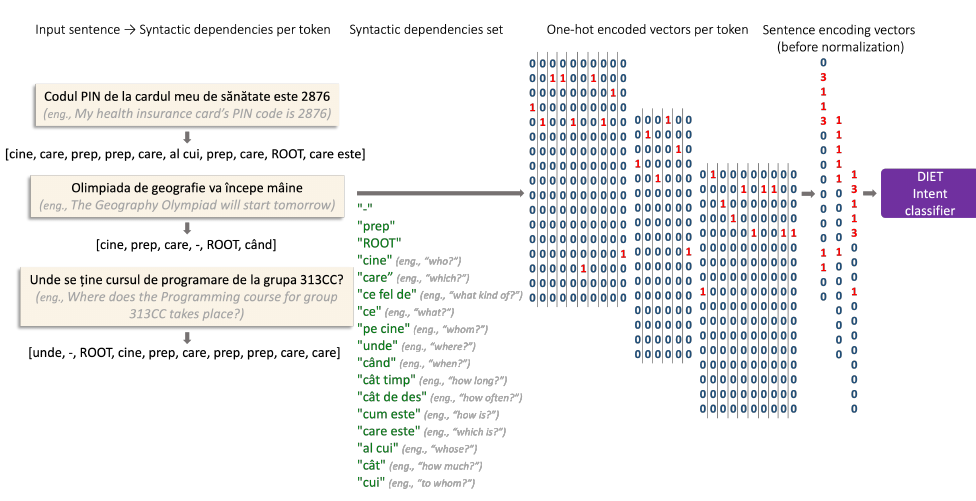
Figure 1. Flow for generating the syntactic